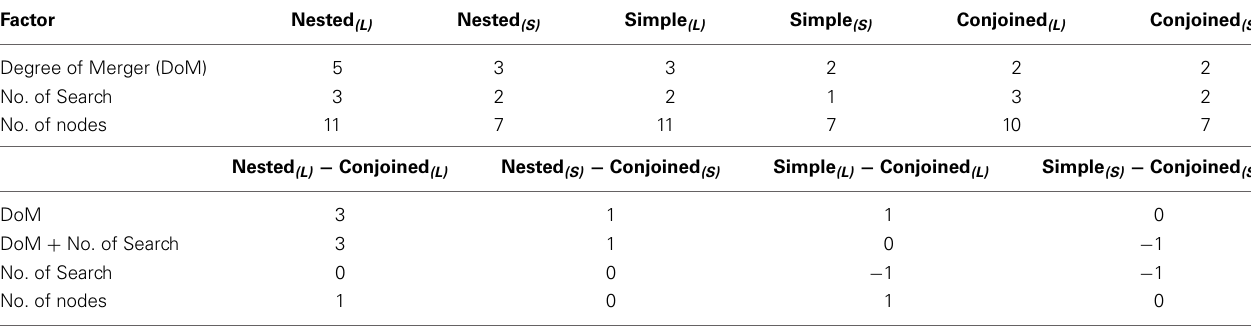
Table 1 | Estimates of various factors to account for activations in Ohta et al. (2013). Factor Nested (L) Nested (S) Simple (L) Simple (S) Conjoined (L) Degree of Merger (DoM)